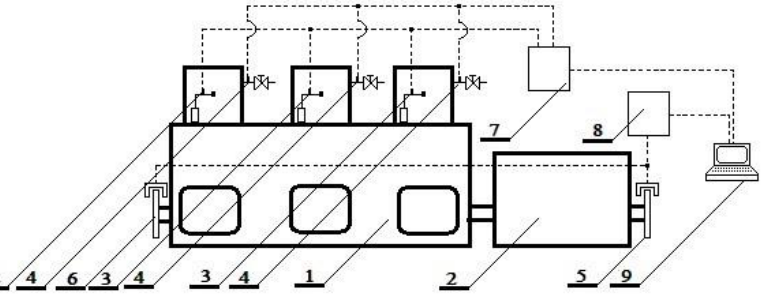
Figure 2. Block diagram of the test stand: 1—SULZER 3AL25/30 marine diesel engine; 2—Domel GD8 500-50/3 synchronous generator; 3—Kistler 4067E sensors for measuring pressure in the injection system; 4—Kistler 6353A24 sensors for measuring combustion pressure; 5,6—ETNP-10 laser